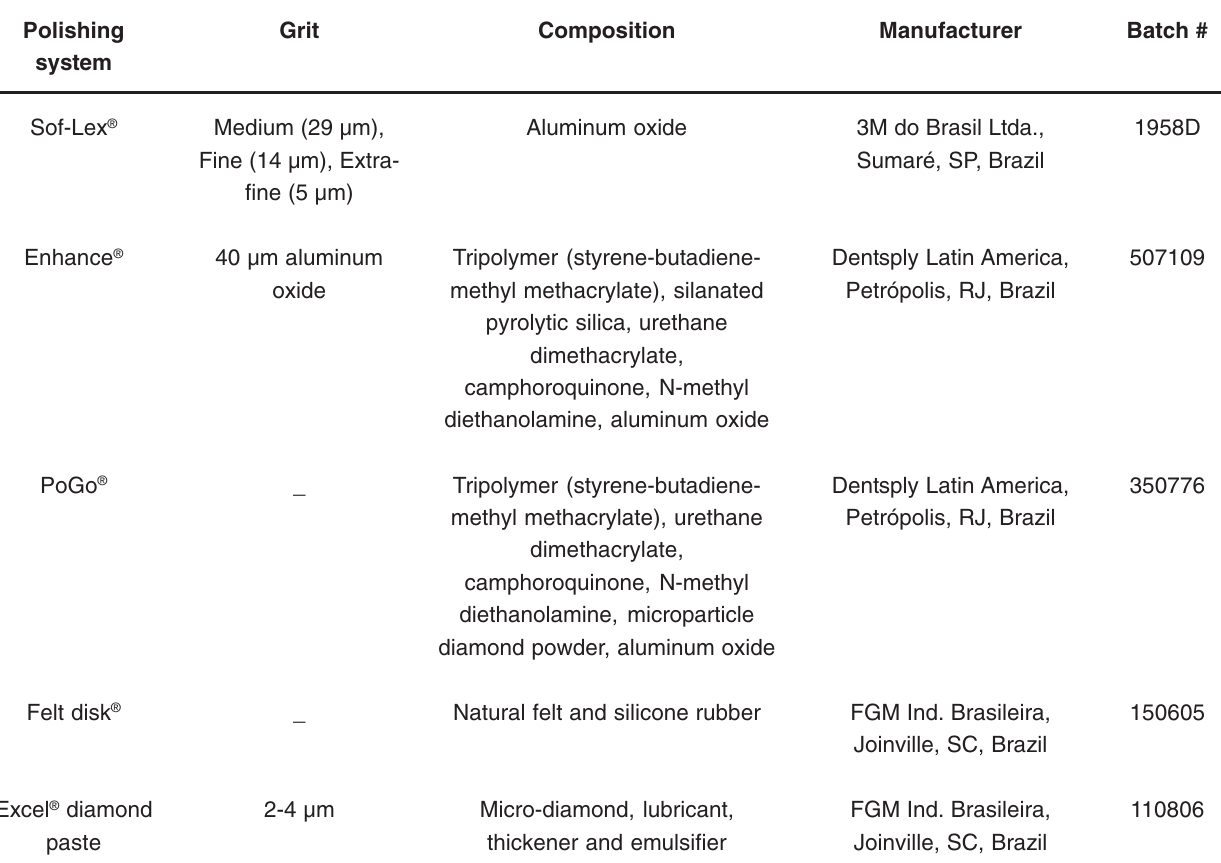
Information supplied by the